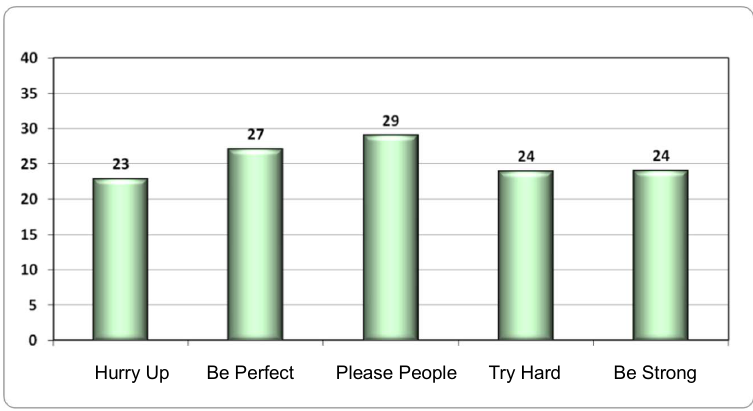
Figure 2. Presence of the five working styles in the profession Legal Advisor